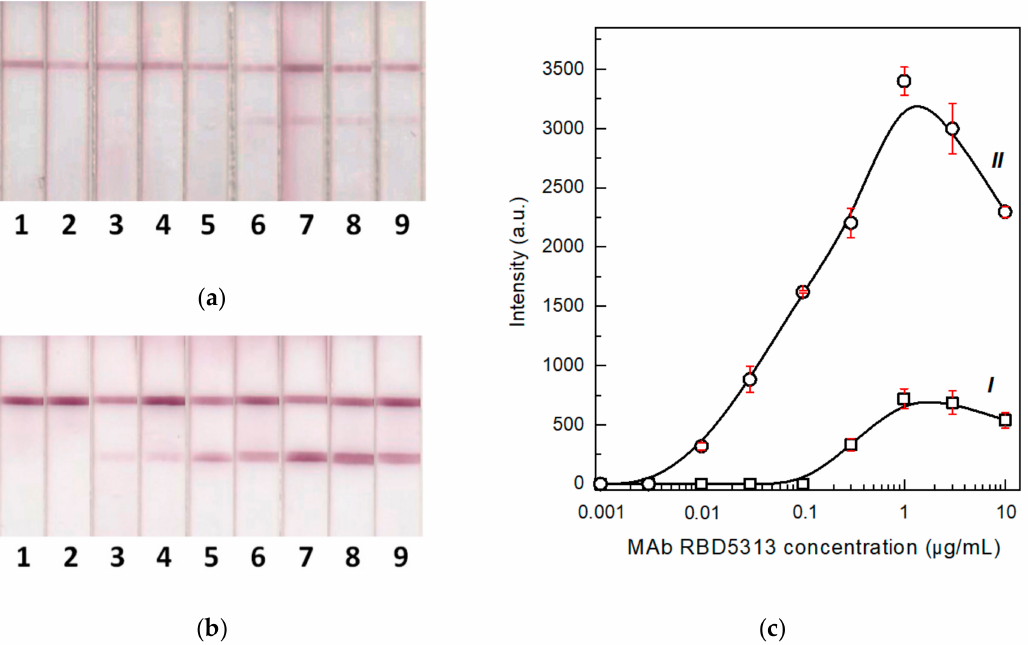
Figure 5. Images of test strips after the common ( a ) and enhanced ( b ) LFIA of samples containing 0 (1), 0.003 (2), 0.01 (3), 0.03 (4), 0.1 (5), 0.3 (6), 1 (7), 3 (8), and 10 (9) µ g/mL of MAb RBD5313. ( c ) Concentration dependence of the common (I) and enhanced (II) LFIA ( n =